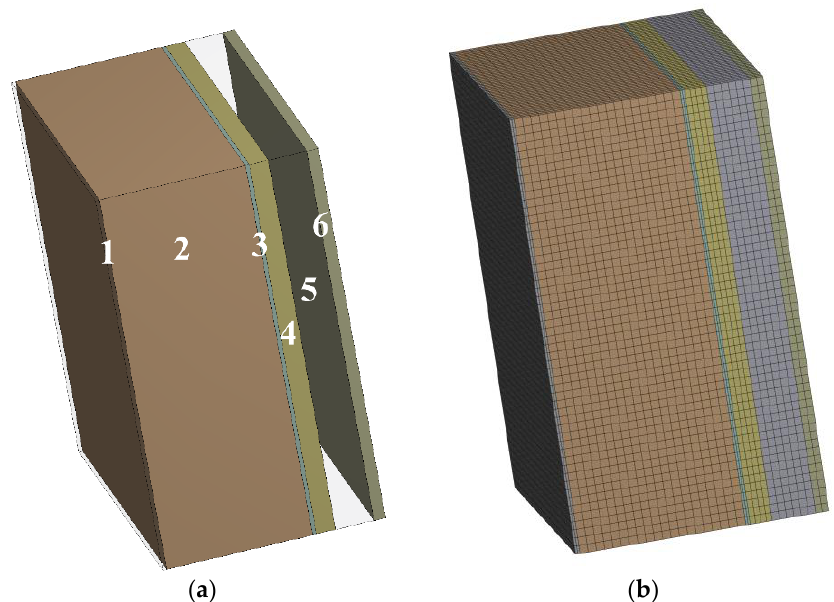
Figure 8. The enclosure section according to Figures 2 – 4: ( a ) sketch: 1, 3 — cement-sand plaster; 2 — bearing layer from ceramic brick; 4, 6 — insulant from extruded polystyrene foam; 5 — closed air gap; ( b ) finite element model.